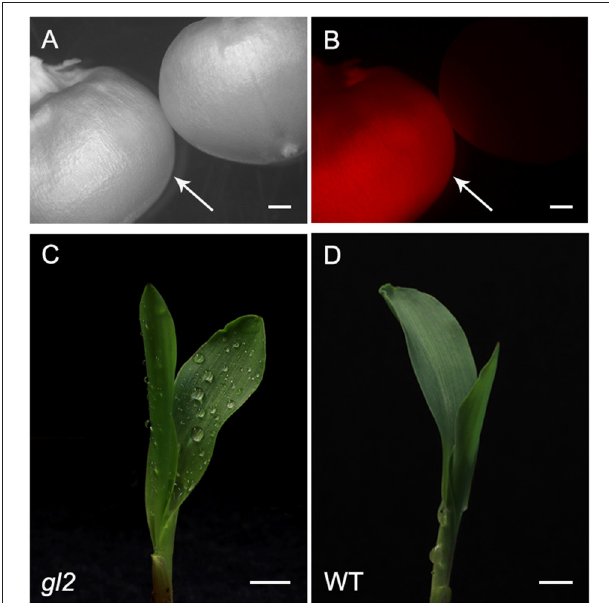
FIGURE 7 | Representative phenotypes of T1 transgenic lines. T1 progeny seed of RFP expressing (left, indicated by an arrow) and non-expressing segregant (right) under bright light (A) and RFP channel (B) . The phenotype of gl2 loss-of-function mutant (C) and wild type (D) . Dull surface of juvenile leaf of gl2 mutant retains sprayed water drops. Bar scale,